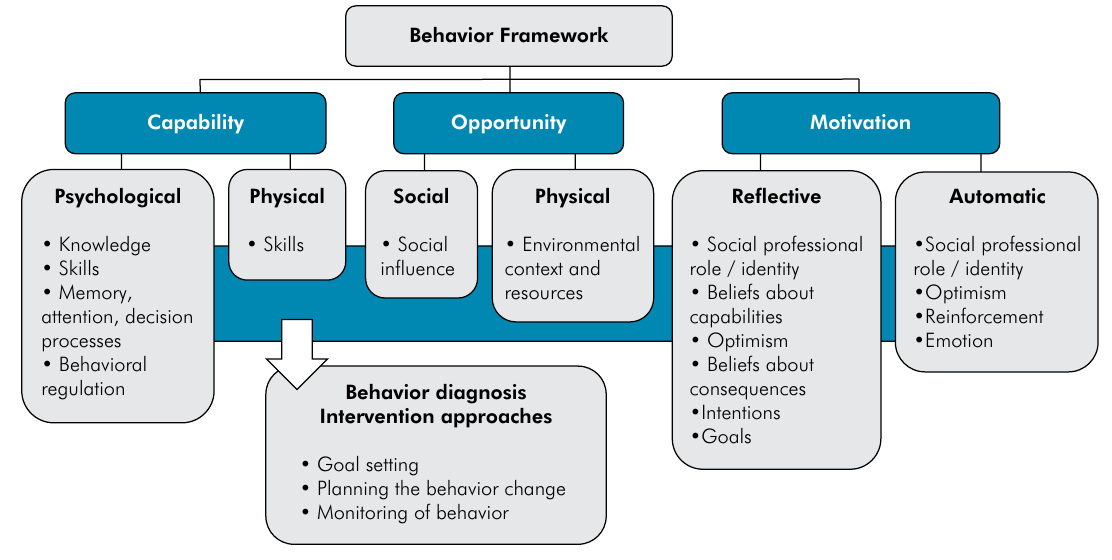
Figure 6. Behavior constructs framework based on Behavioral models for periodontal health and disease. Adapted from Newton and Asimakopoulou.